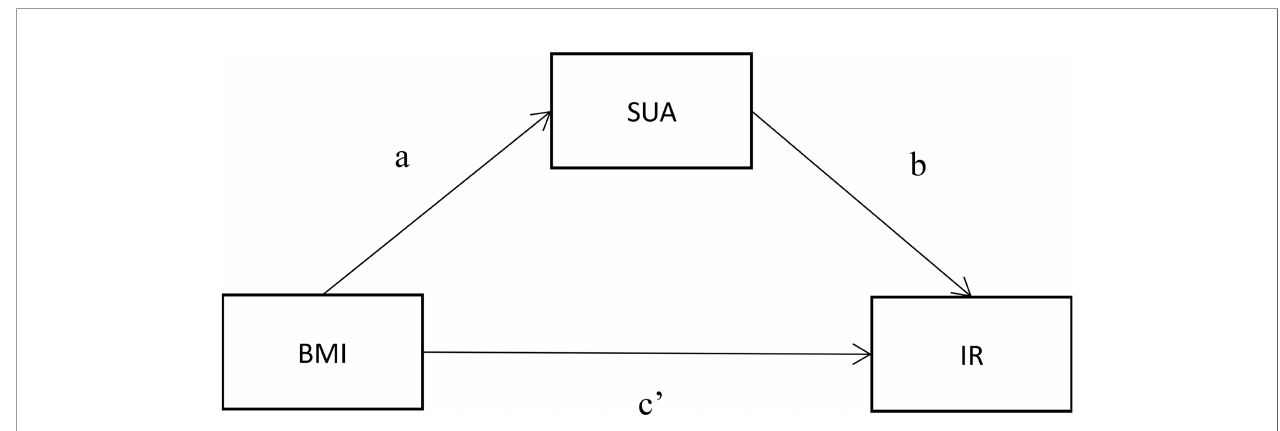
FIGURE 2 | Mediation model for the association between BMI and IR with SUA as a mediator. (A) represents the regression coef fi cients for the association between BMI and SUA; (B) represents the regression coef fi cients for the association between SUA and glucose metabolism; (C ’ ) represents the total effect between BMI and glucose